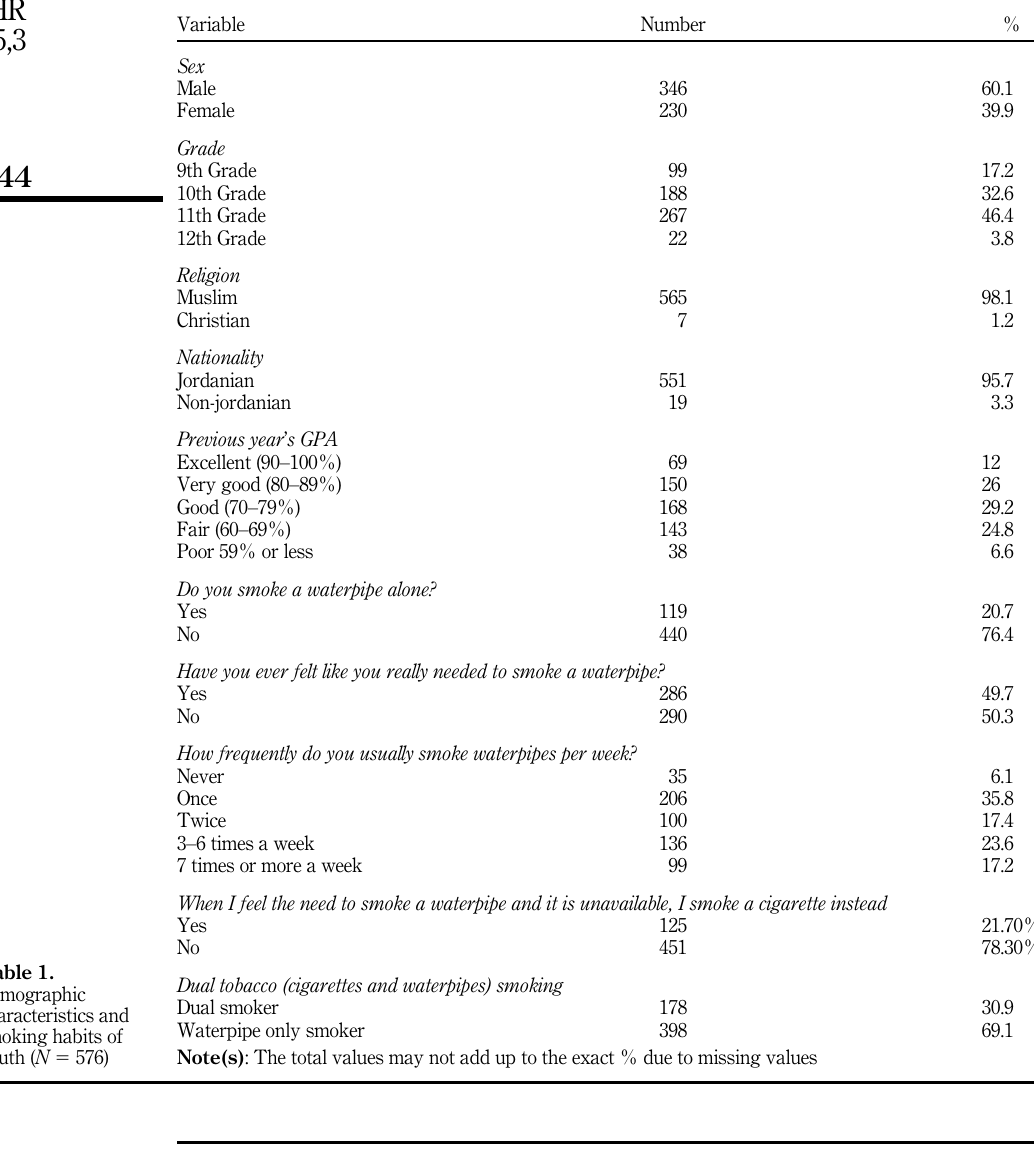
Table 2. Distribution of dual tobacco use according to sex ( n 5